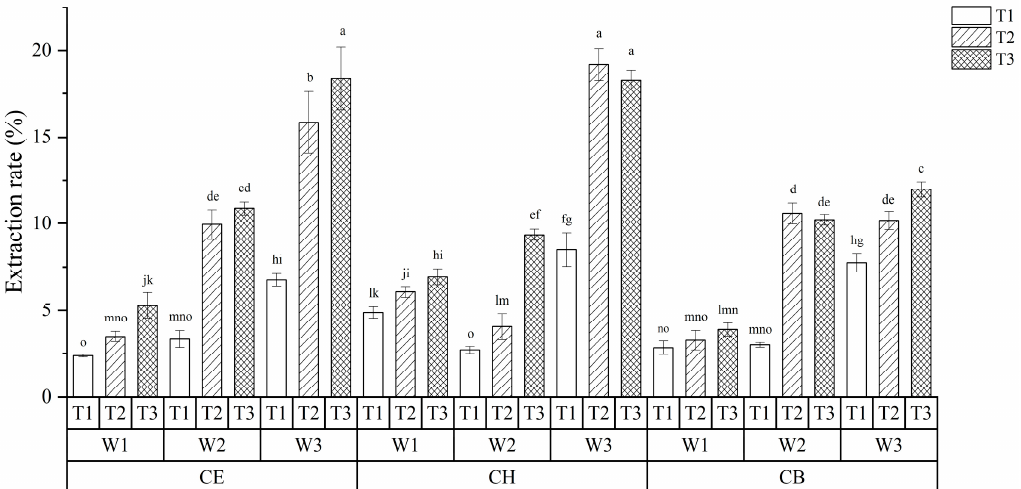
Figure 1. The yield of tea polysaccharides (TPs) under different extraction solvents, ultrasonic time and water content. T: Extraction time, 1, 2, and 3 mean 20, 40, and 60 min. W: Water content, 1, 2, and 3 mean 10%, 20%, and 30%. CE: Choline chloride and ethylene glycol, 1:2 molar ratio; CH: Choline chloride and 1,6 hexanediol, 1:2 molar ratio; CB: Choline chloride and 1,4-butanediol, 1:4 molar ratio; Means with different letters indicate a significant difference ( p < 0.05). Table 2. The independence or interactive effects of deep eutectic solvents (sol), water contents (water), and ultrasound extraction times (time) on tea polysaccharides yield were analyzed based on analysis of variance (ANOVA)